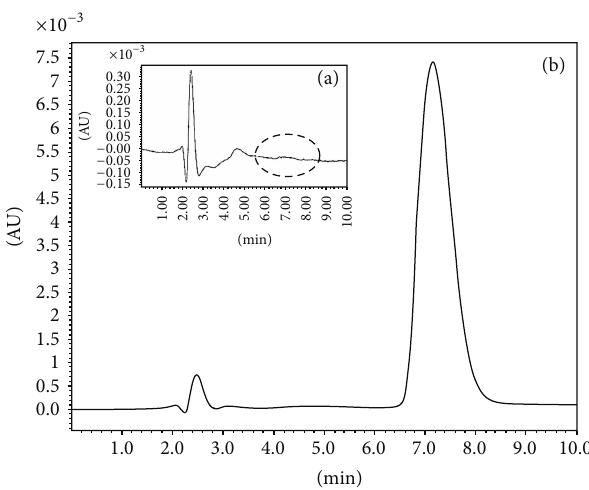
Figure 2: Chromatogram of (a) extracts from blank nanocarriers and (b) mixture of 25 𝜇 g/mL of FUR (w/vol) with blank nanocarri-